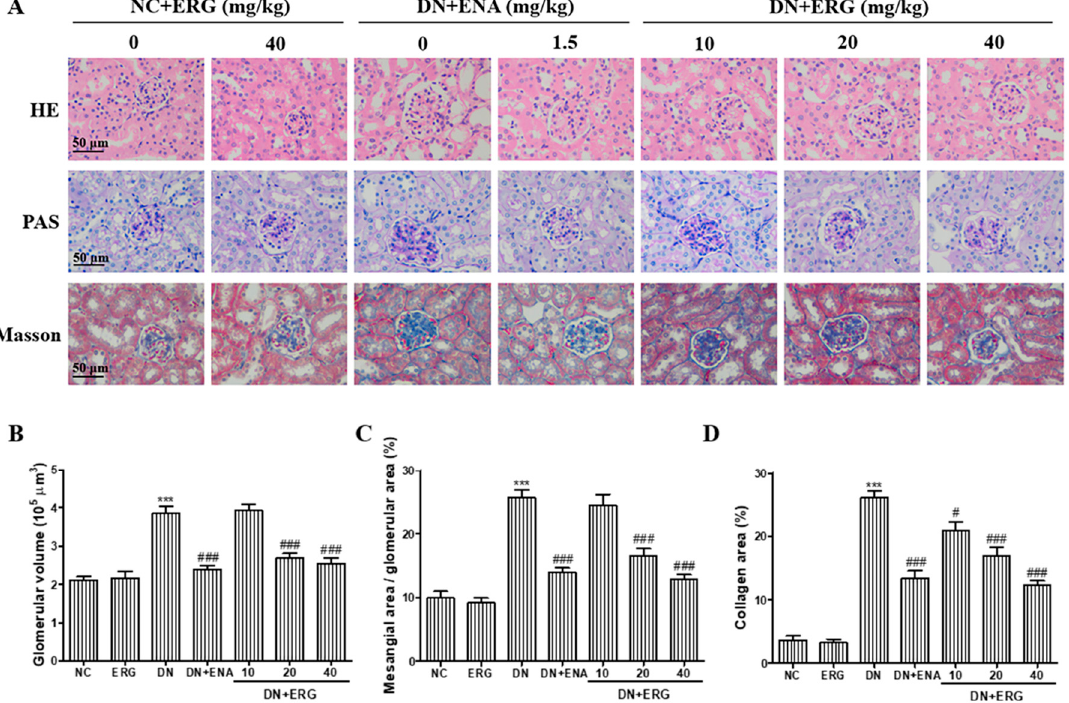
Figure 3. Effects of ergosterol on histopathological changes in the renal tissues of STZ-induced diabetic mice. ( A ) Representative hematoxylin-eosin (HE), periodic acid-Schiff (PAS) and Masson staining in kidneys from formalin-fixed kidney sections taken from the mice of each group ( n = 6/group) at 8 weeks. ( B – D ) Quantitative assessment of glomerular volume, mesangial area (%), and collagen area (%). NC: normal control; DN: diabetic nephropathy; ENA: enalaprilat administration;